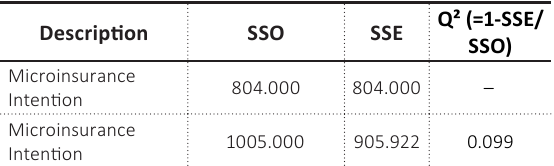
Table 8. Construct cross-validated redundancy